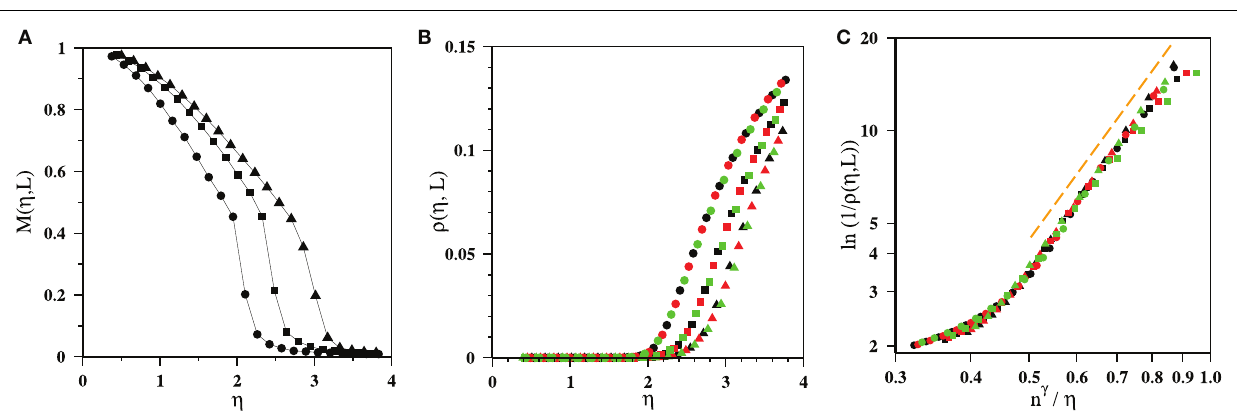
FIGURE 18 | The behavior of different quantities against noise for lattice sizes L = 32 (black), 64 (red), and 128 (green) with values of n = 2 (circle), 3 (square), and 4 (triangle). (A) The variation of the order parameter M ( η , L ) against noise η are shown for L = 128 and for n = 2, 3, and 4. (B)